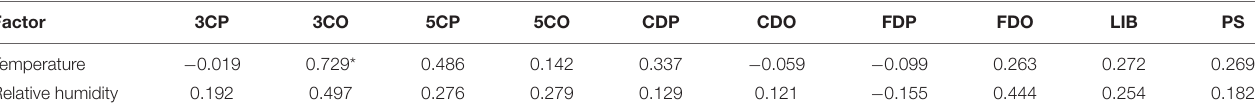
FIGURE 4 | Fungal colony concentration variations in each location at different seasons. 3CP, Canteen 3 Peak; 3CO, Canteen 3 Off-peak; 5CP, Canteen 5 Peak; 5CO, Canteen 5 Off-peak; CDP, Chinese student Dorm Peak; CDO, Chinese student Dorm Off-peak; FDP, Foreign student Dorm Peak; FDO, Foreign student Dorm Off-peak; LIB, Library; PS, Peiyang Square. TABLE 3 | Pearson correlation analysis between fungal concentration and environmental factors from different sampling